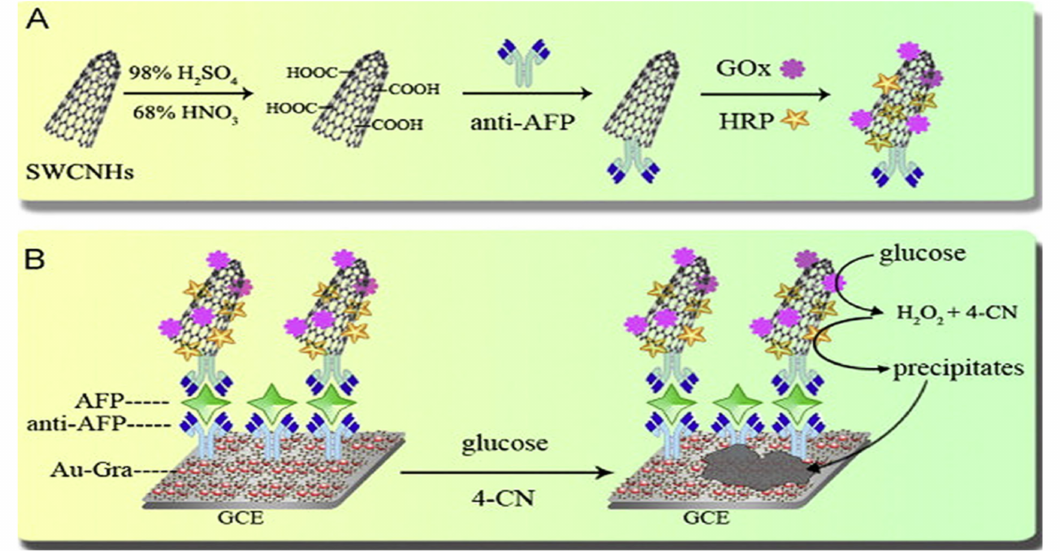
Figure 14. Preparation immunosensor (SWCNHs) based on electrochemical impedance spectroscopy ( A ) Stepwise functionality of a modified electrode ( B ), Modified glassy carbon electrode (GCE) by Au-Gra layer and anti-AFP antibody. Therefore, AFP will be detected in a sandwich configuration. Reprinted by permission from [109]. Copyright 2018 John Wiley and Sons.